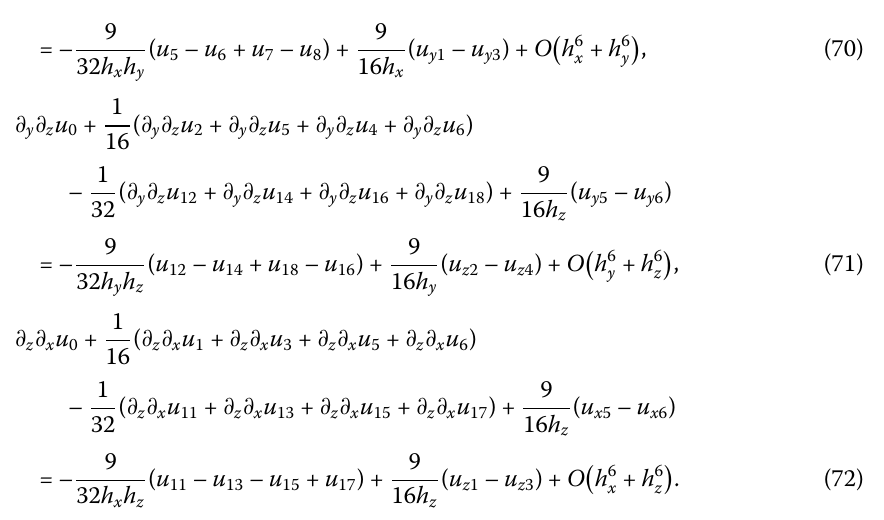
The left boundary format discrete template is shown in Fig. 2.